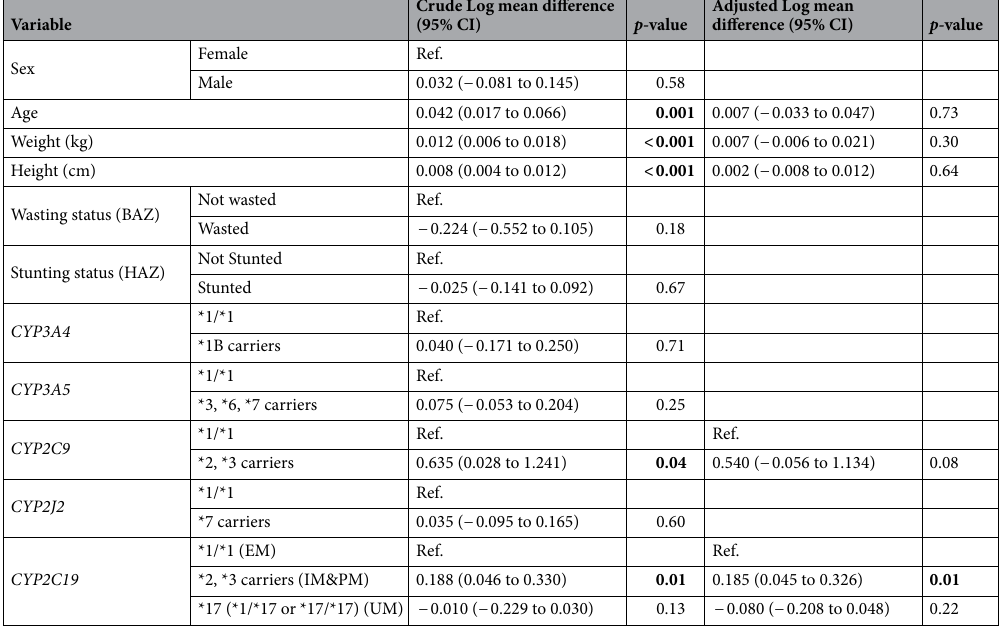
Table 3. Factors associated with plasma praziquantel concentration (ng/mL). BAZ body mass index (BMI) for age Z score, EM extensive metabolizers, HAZ height for Age Z score, PZQ praziquantel, IM intermediate metabolizers, UM ultrarapid metabolizers. Significant values are in bold.